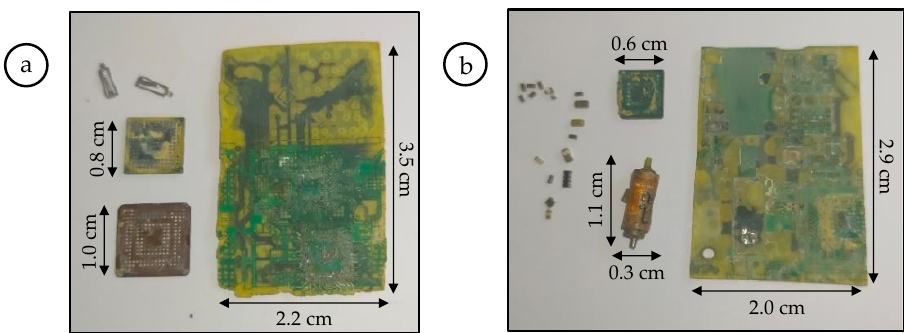
Figure 7. Eroded circuit board and detached pieces (e.g., attachment clips, microchips, capacitors and submillimetrical components, such as resistors) after leaching with Fe 3+ in ( a ) biotic and ( b ) abiotic medium.